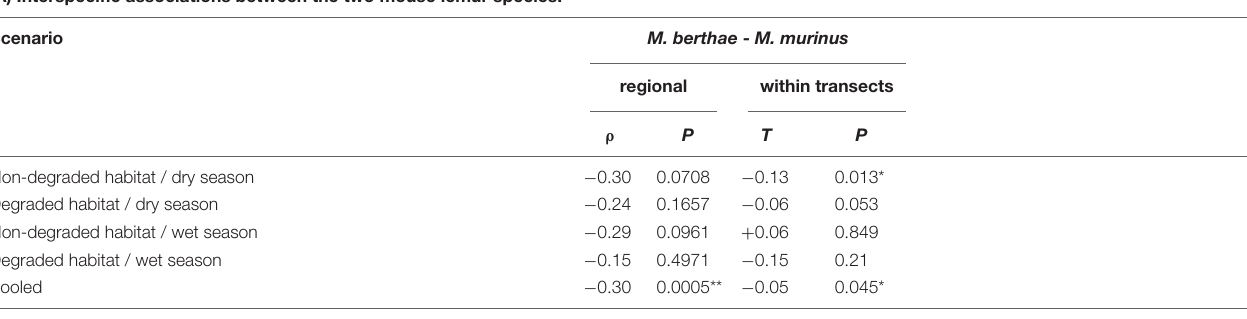
TABLE 4 | (A–C) Interspecific correlation coefficient for individual numbers on transects and index T (Eq. 1) measuring interspecific aggregation within transects for five species combinations and four different scenarios. (A) Interspecific associations between the two mouse lemur